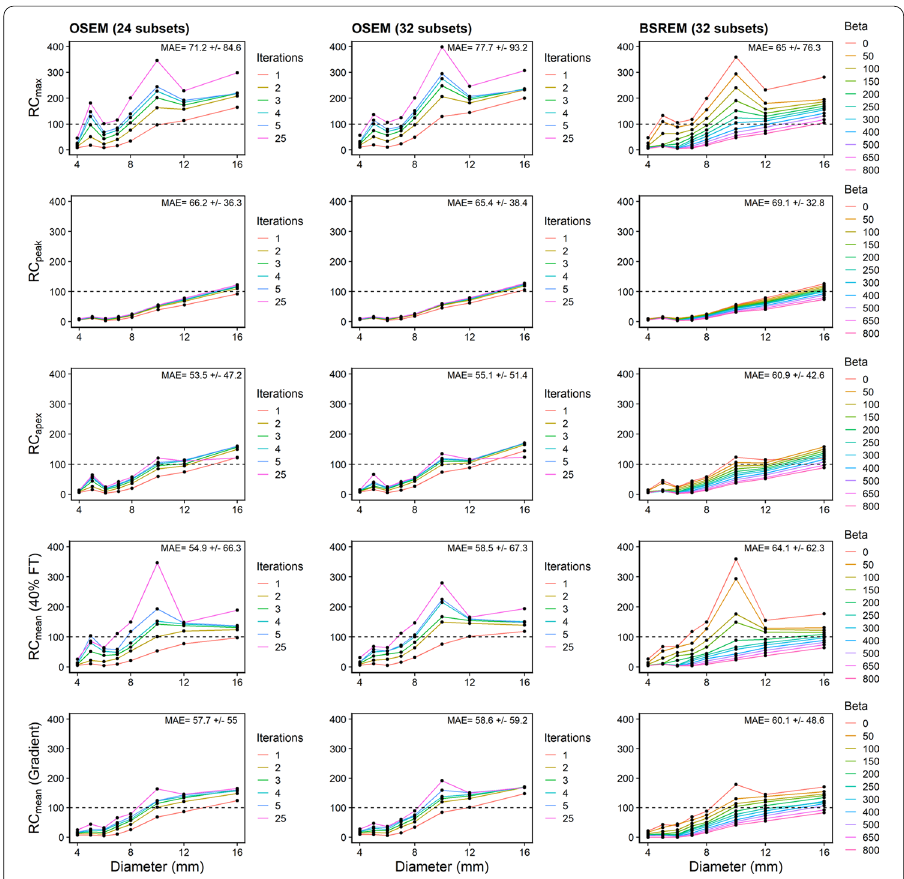
Fig. 6 Recovery curves. (Top to bottom) Recovery concentration coefficients measured in Probe-IQ pelvis using Max, Peak, Apex, and Mean (40% FT and gradient). (Left to right) Reconstruction algorithms using OSEM PSF (24 and 32 subsets, respectively) and BSREM. Mean absolute error (MAE) + indicated on each